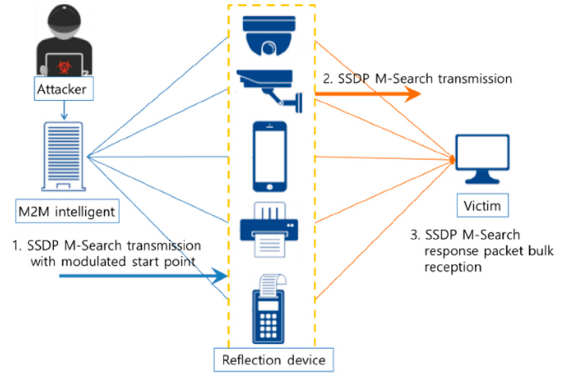
Figure 2. DRDoS attack using M2M intelligent network.